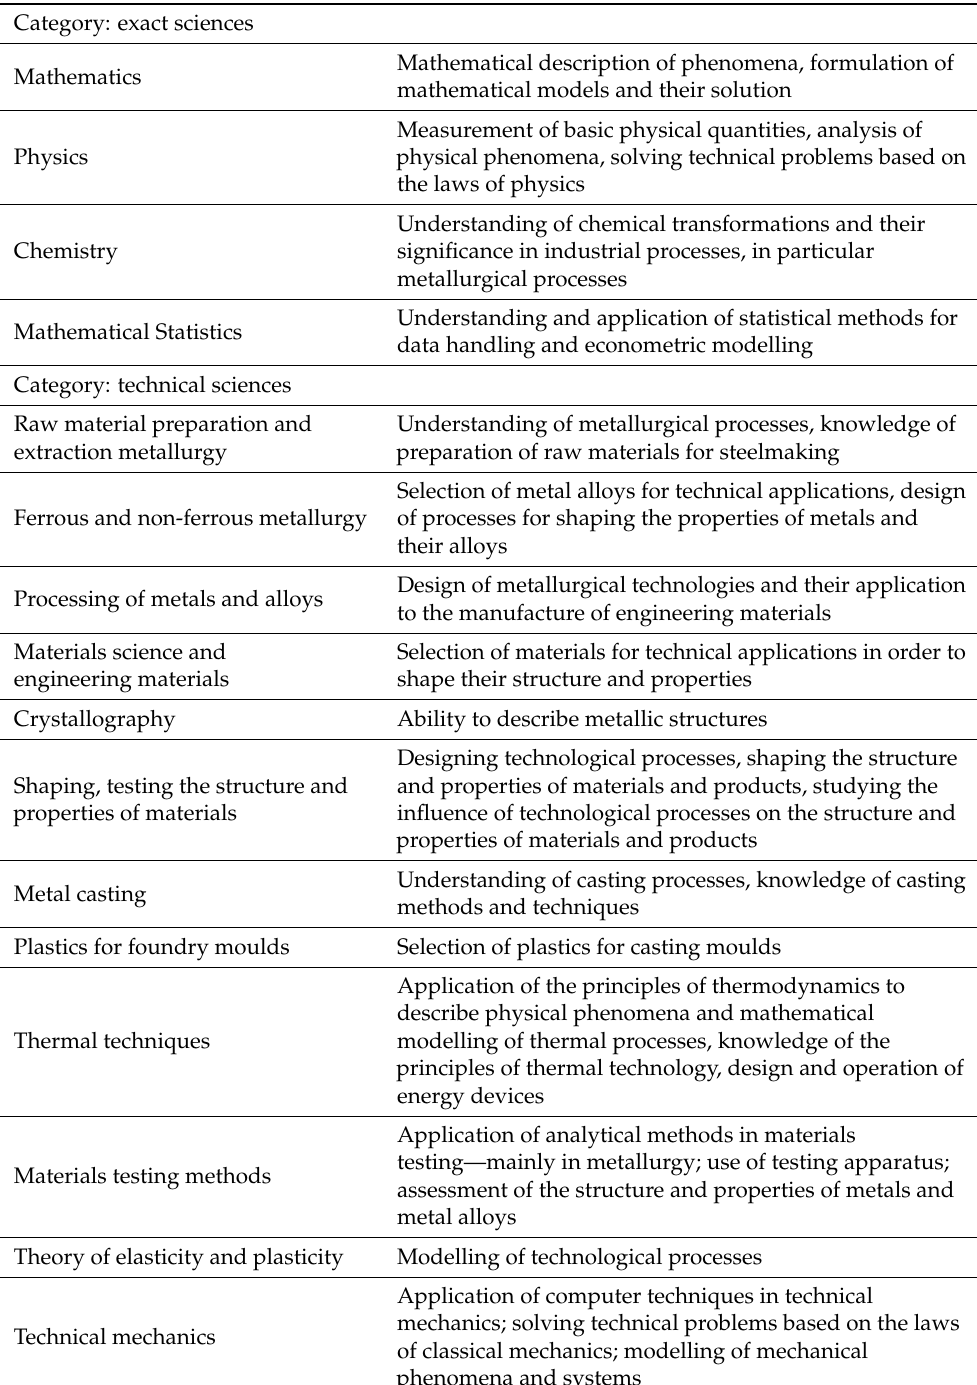
Table 6. Profile of a metallurgy graduate case study based on educational programmes in